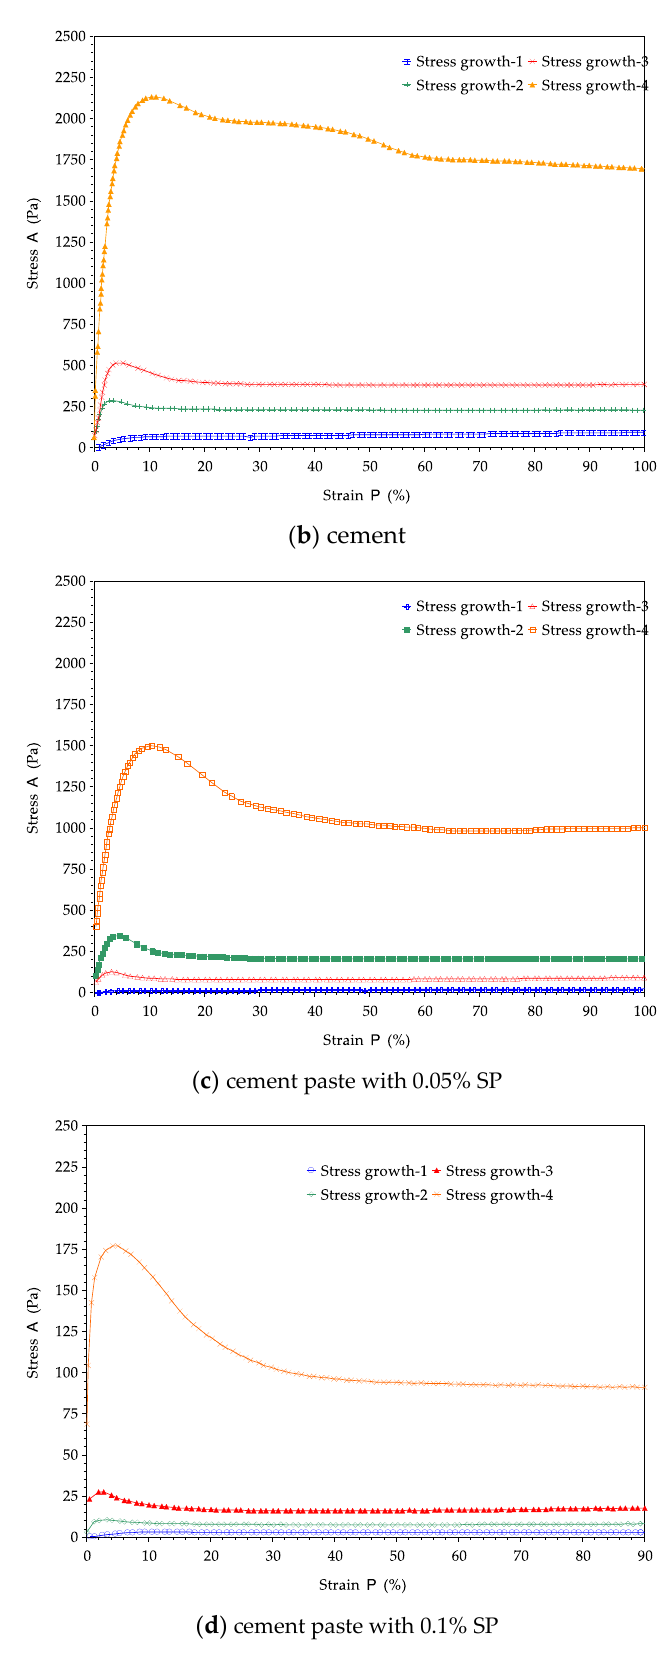
Figure A2. Example of the yield stress measurements of calcite ( a ), cement paste ( b ), cement paste with 0.05% SP ( c ), and cement paste with 0.1% SP ( d ) during Procedure 1.